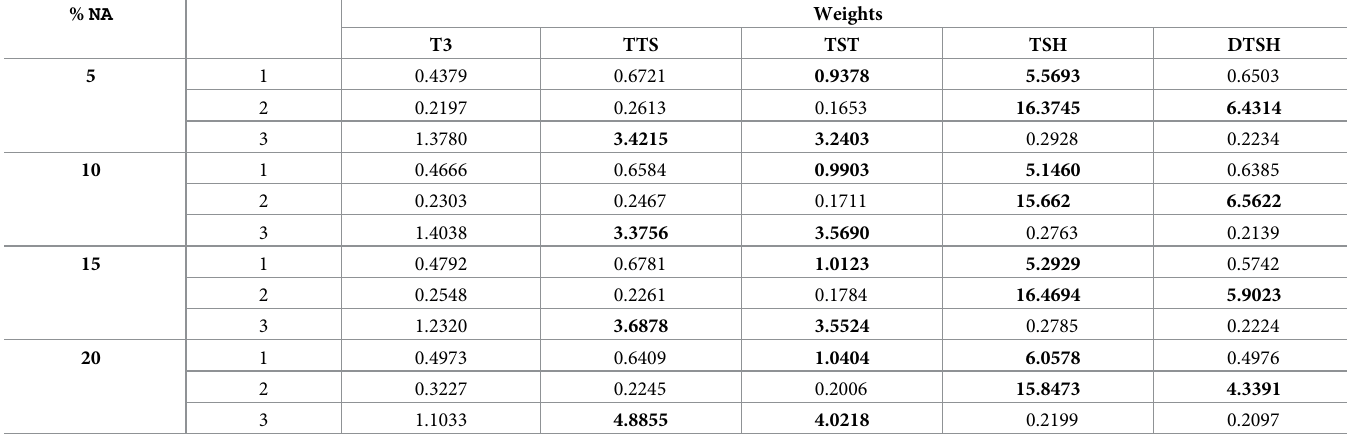
Table 10. Weights of the variables in each group found by the VKFCM-K-LP algorithm with the PDS strategy under different percentages of missing